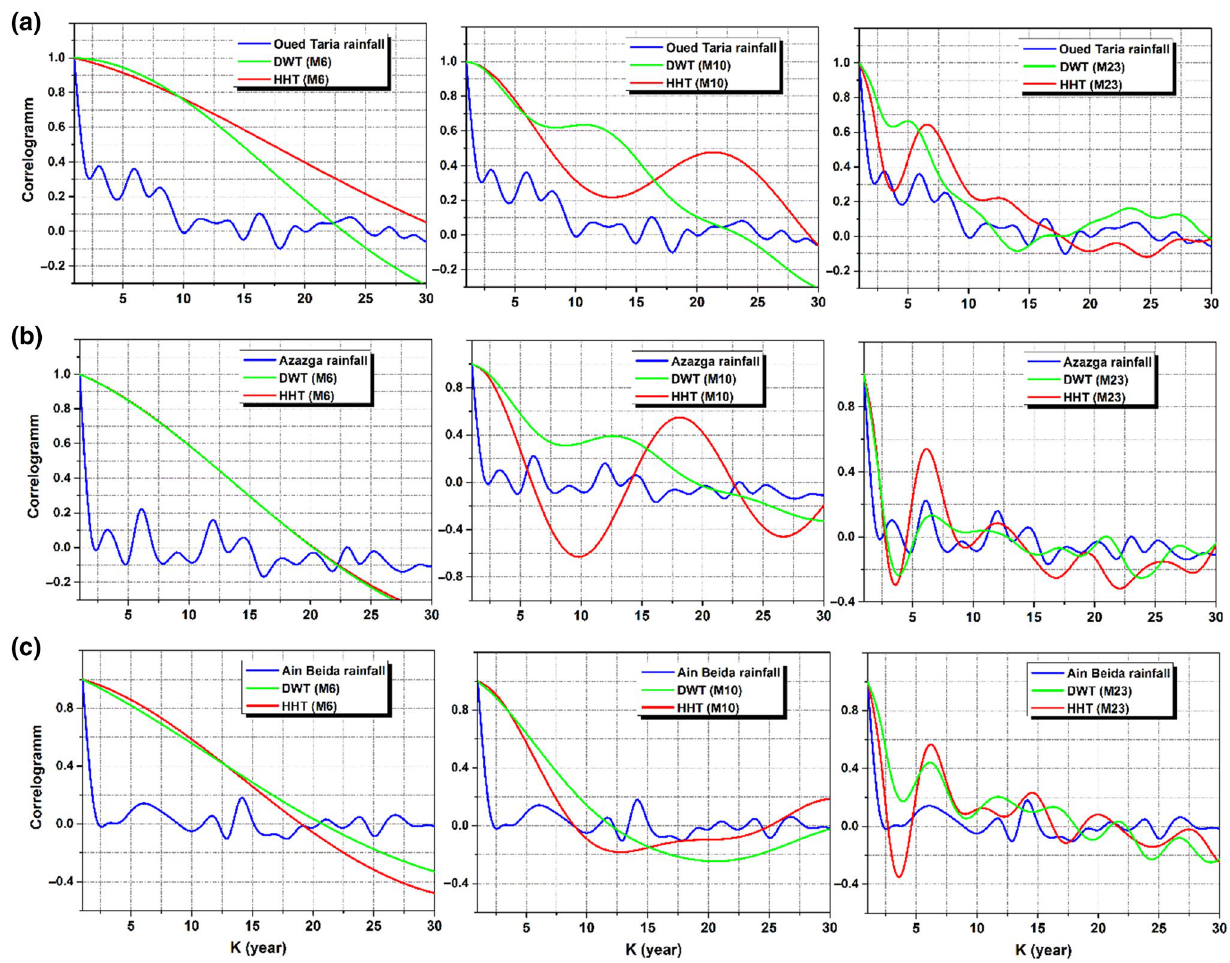
Fig. 10 Correlogram analysis of rainfall series (blue line), and some proposed models (M6, M10, and M23) using DWT (green line) and HHT (red line) for a Oued Taria, b Azazga, and c Ain Beida